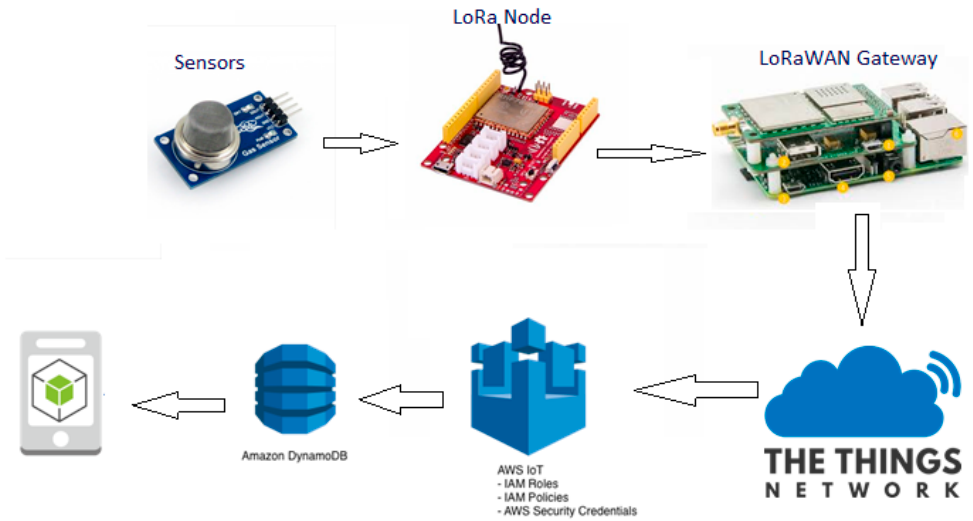
Figure 3. Communication Architecture for the experimental setup.